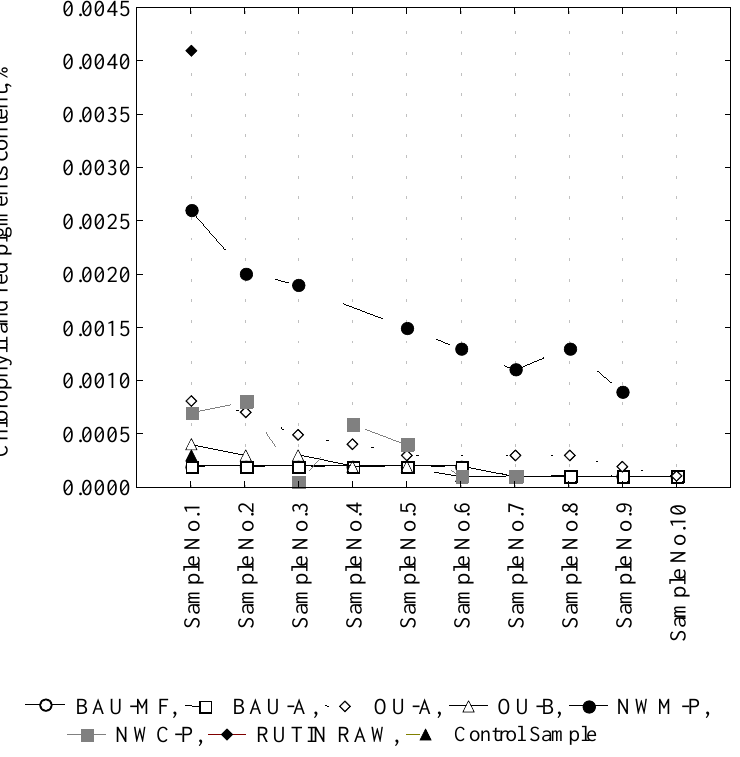
Fig. 6. Dependence of flavonoid amount content in rutin samples on adsorbent layer height.